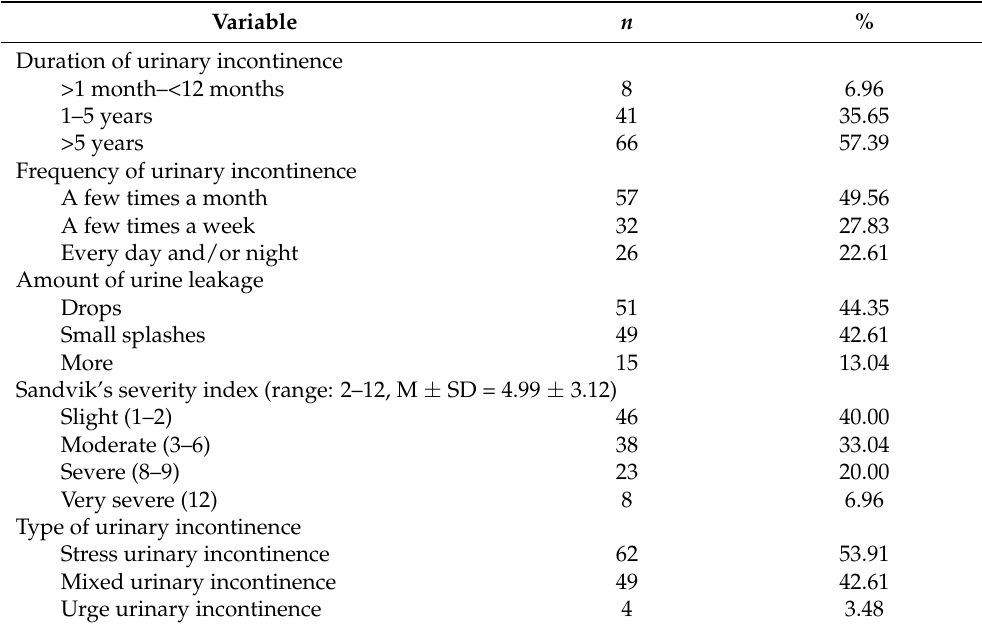
Table 2. Symptom-related conditions in participants with urinary incontinence ( n = 115). Variable